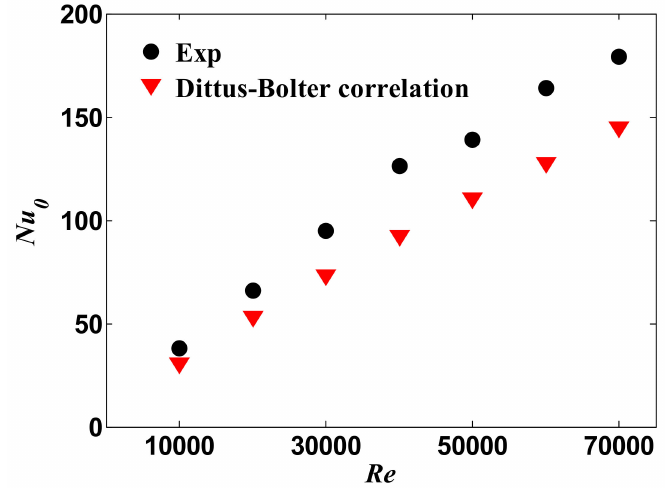
Figure 3. Comparison of baseline Nu 0 with empirical data.